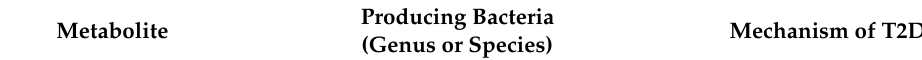
Table 2. Main microbial metabolites related to